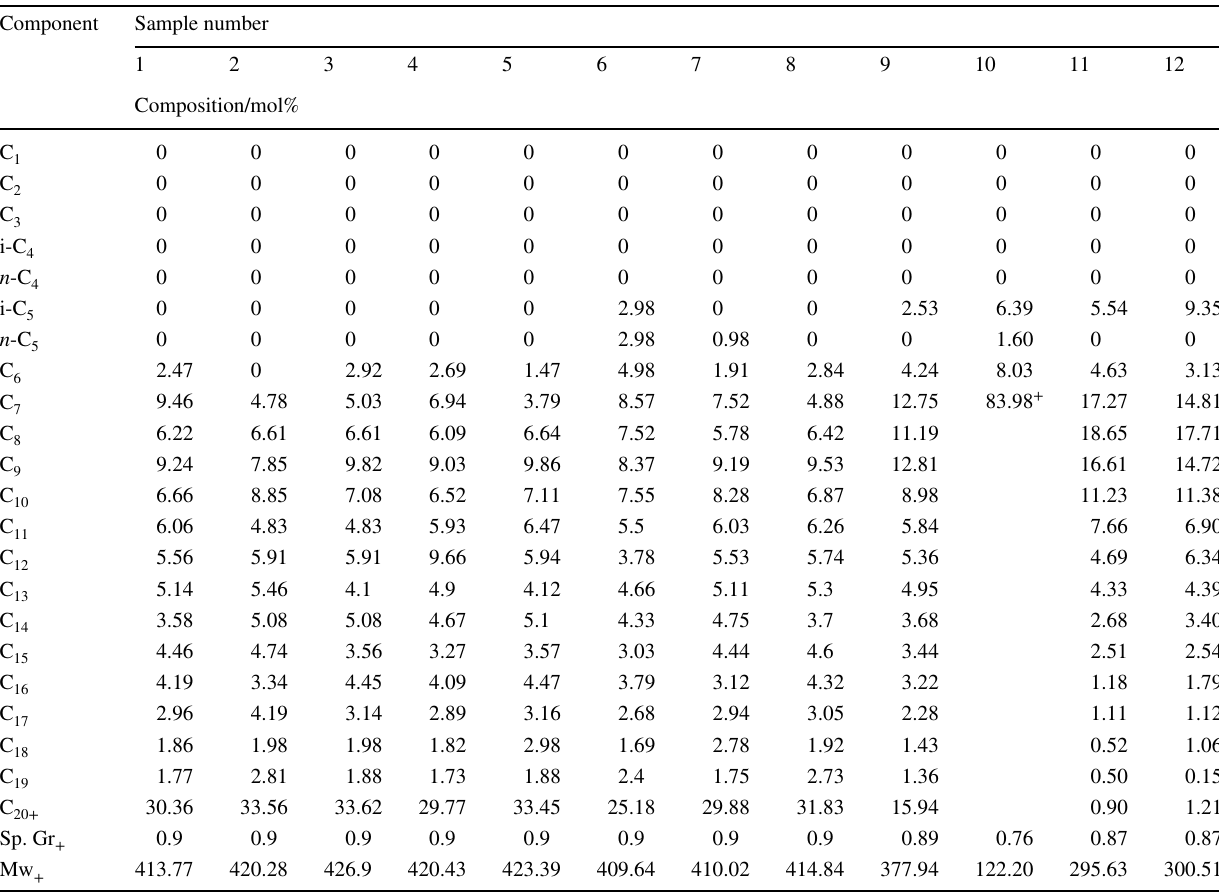
Table 1 Composition of 12 crude oils and condensate samples